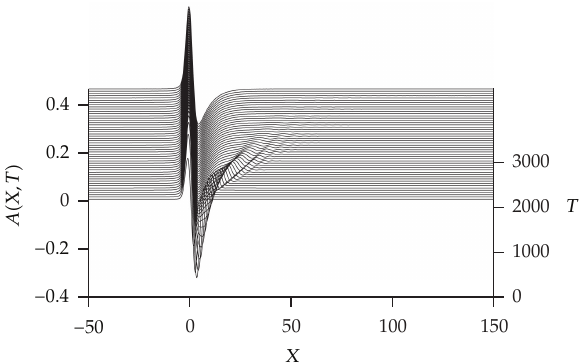
Figure 4: Solitary waves generated by topography in the presence of dissipation λ (cid:9) 0 . 3 × 10 − 2 , α (cid:9) 1 . 5 × 10 − 2 .